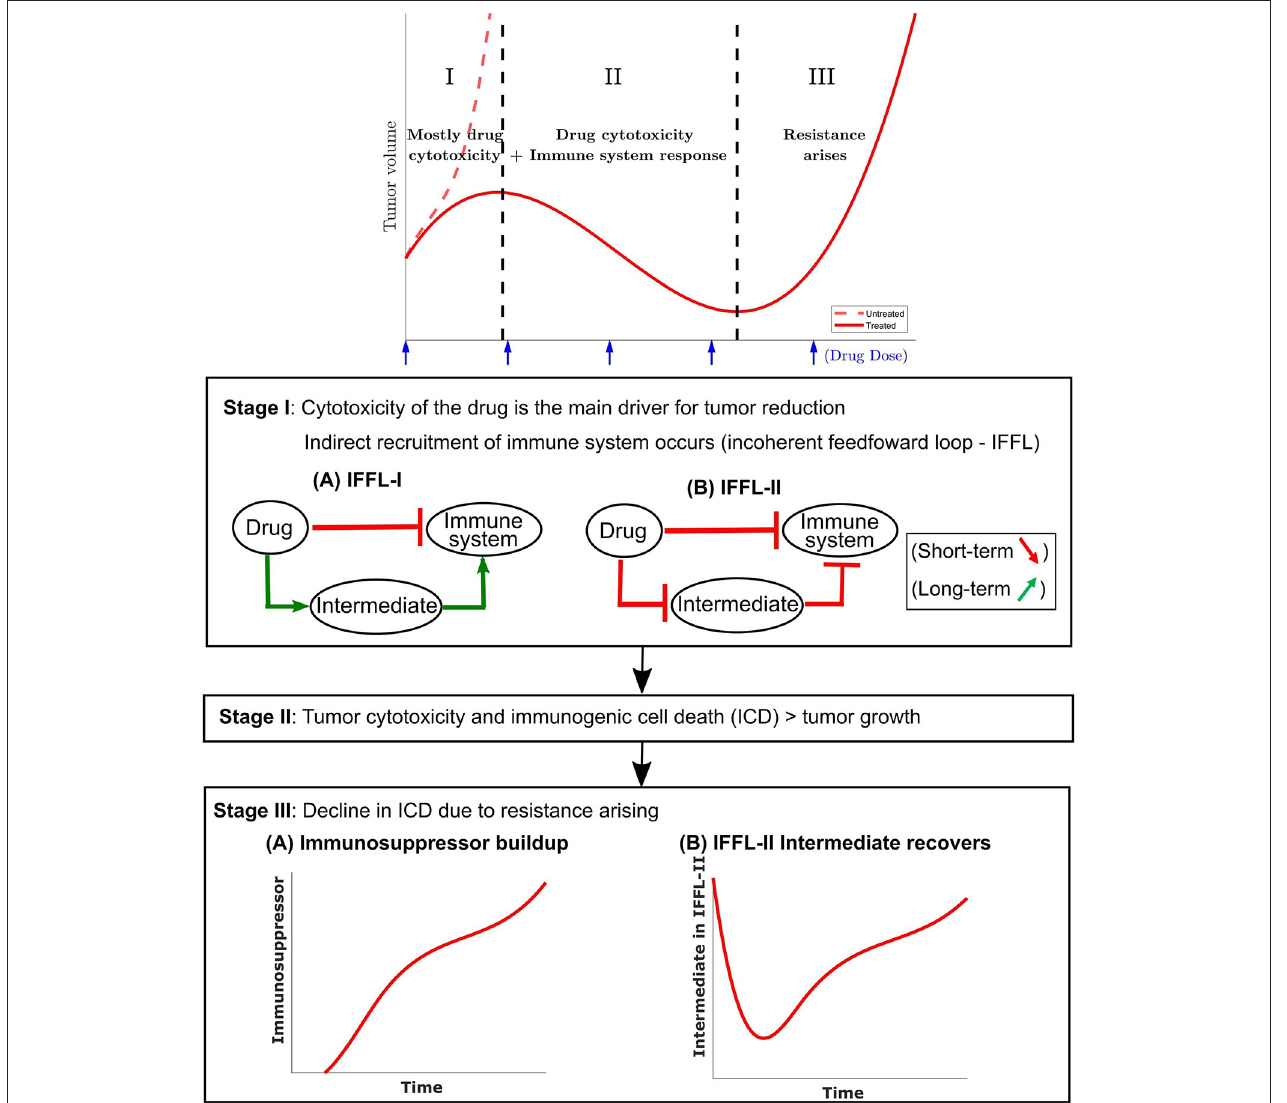
FIGURE 2 | A conceptual tumor growth curve under metronomic chemotherapy treatment with repeated doses is shown and is broken down into three representative stages. In stage I, tumor growth is primarily inhibited by the direct tumor cell cytotoxicity of the drug. There is typically a delay in the immune response due to the immune cell cytotoxicity of the injected drug. The immune cell data in Wu and Waxman (12) indicate that an immune response is substantially reduced immediately after drug administration, but eventually recovers and leads to a strong response 6–12 days later. Two possible incoherent feed-forward loop (IFFL) motifs that capture these short-term and long-term dynamics of the drug-immune system interactions are shown. In stage II, the tumor volume is typically reduced as the induced immune response becomes the principal contributor to tumor cell death. Stage II lasts until the induced immune response fades due to the emergence of drug resistance. Stage III typically has the tumor recovering its ability to grow in an exponential fashion. Two possible scenarios are shown with the occurrence of an immunosuppressor build up or recovery of the intermediate in an IFFL-II